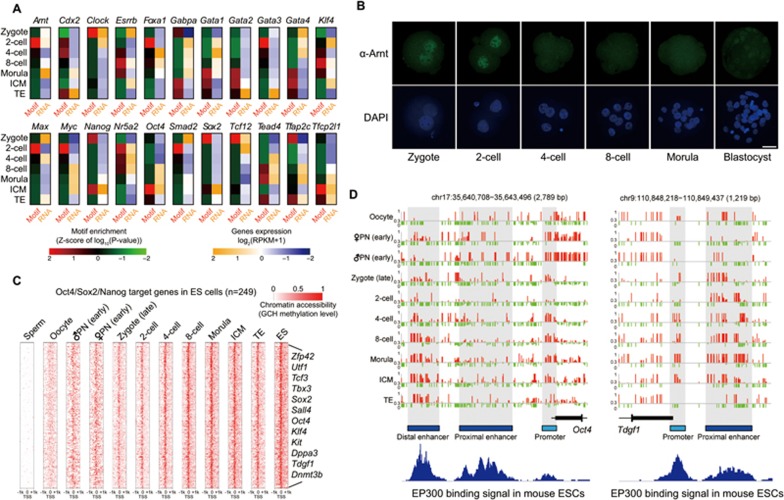
Chromatin remodeling dynamics of putative distal regulatory regions during mouse preimplantation development. (A) Motif enrichment analysis of distal NDRs detected in preimplantation embryos. The z-score of P-value of corresponding gene motifs and their RNA expression levels are given. (B) Fluorescence immunostaining of Arnt in mouse preimplantation embryos. Scale bar, 25 μm. (C) Dynamics of chromatin accessibility around TSS of 249 Oct4/Sox2/Nanog target genes62 that were open in mouse ES cells during preimplantation development. (D) Representative of Oct4 gene and Tdgf1 gene show the chromatin accessibility (GCH methylation level at single-base resolution) at their corresponding cis regulatory elements (promoters and enhancers) during preimplantation development.